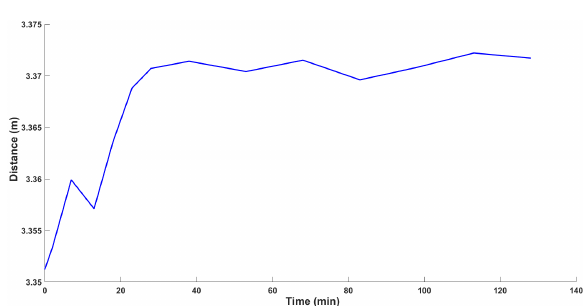
Figure 1. Drift analysis showing the variation of distance measurement with respect to time 3.2 Effect of Surface Colors The laser is usually affected by the color of the target surface. In order to evaluate the LiDAR’s performances with respect to different colors, the three primary colors red, green, blue and two secondary colors black and white and also a shiny silver (high reflectivity) color were tested. Each of these 6 colored targets are all the same material of papers and were all fixed on exactly the same place during each test. The results, in the form of distance distributions, are presented in Figure 2.